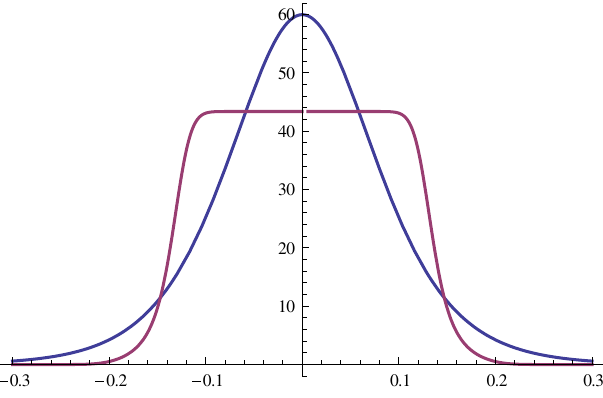
FIG. 8. Gradient (in T/m) vs z (in m) for a conventional quadrupole (purple), compared with a sech 2 strength quadrupole of the same strength